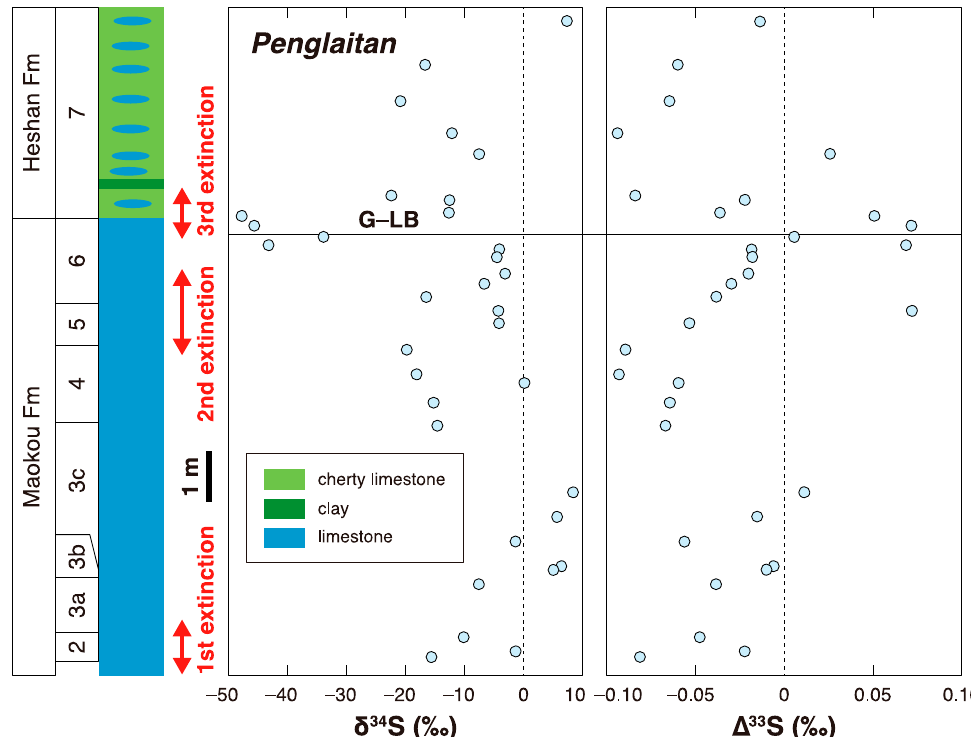
Figure 3. Multiple sulfur isotope chemostratigraphy across the Guadalupian-Lopingian boundary (G-LB) at Penglaitan [69]. A number along the log is Bed number. The estimated three extinction intervals are after Shen and Shi [79] and Huang et al. [80].